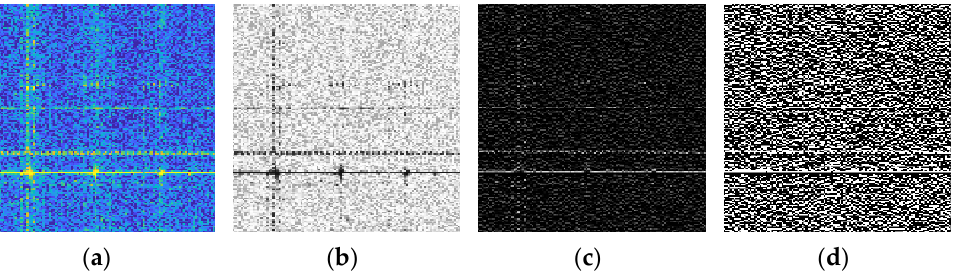
Figure 5. Data preprocessing: ( a ) spectrogram; ( b ) grayscale; ( c ) extraction of horizontal features; ( d ) binarization.